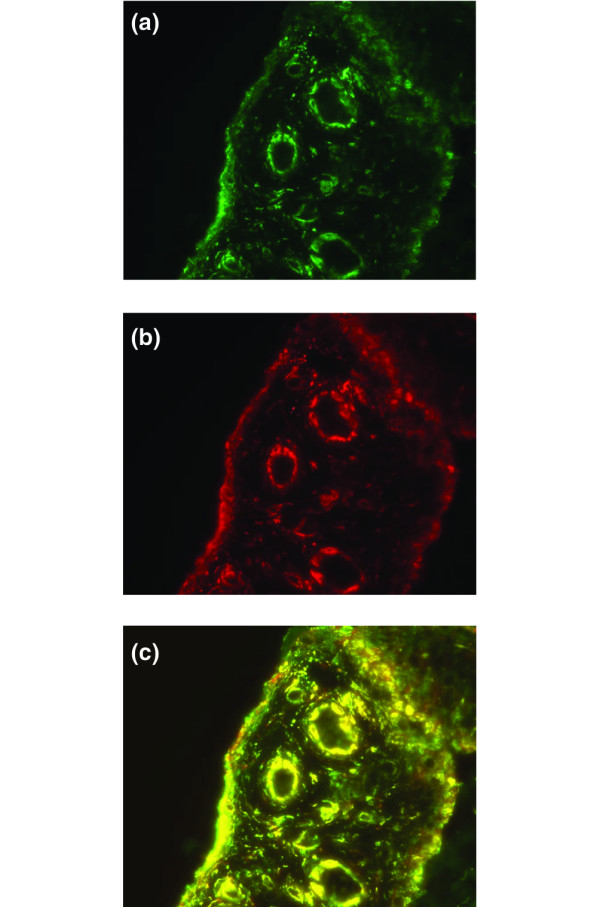
Co-expression of CD163 (macrophages) and IL-15 in the synovial tissue. Immunofluorescence staining of synovial tissue in rheumatoid arthritis of CD163 (a) and IL-15 neutralizing antibody (b) and double staining with CD163 and IL-15 (c). Original magnification × 250.